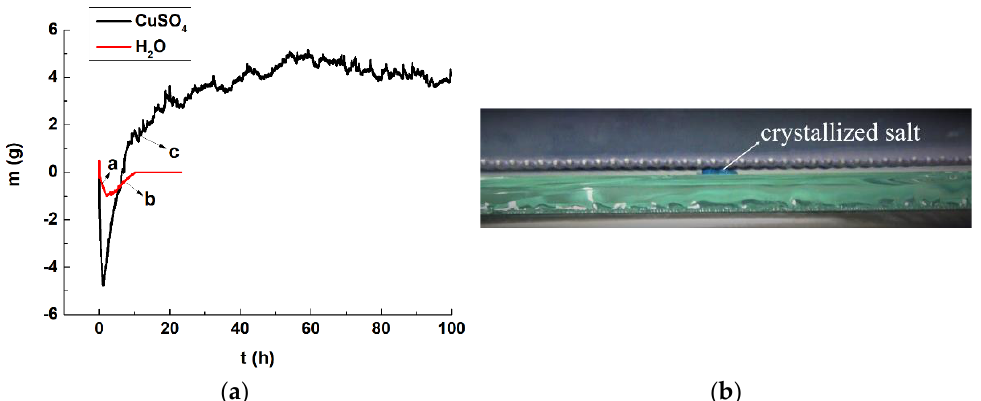
Figure 10. The change in mass of the salt solution and water tested by the double-layer contact surface internal press method ( a ) mass change curves; ( b ) crystallized salt.